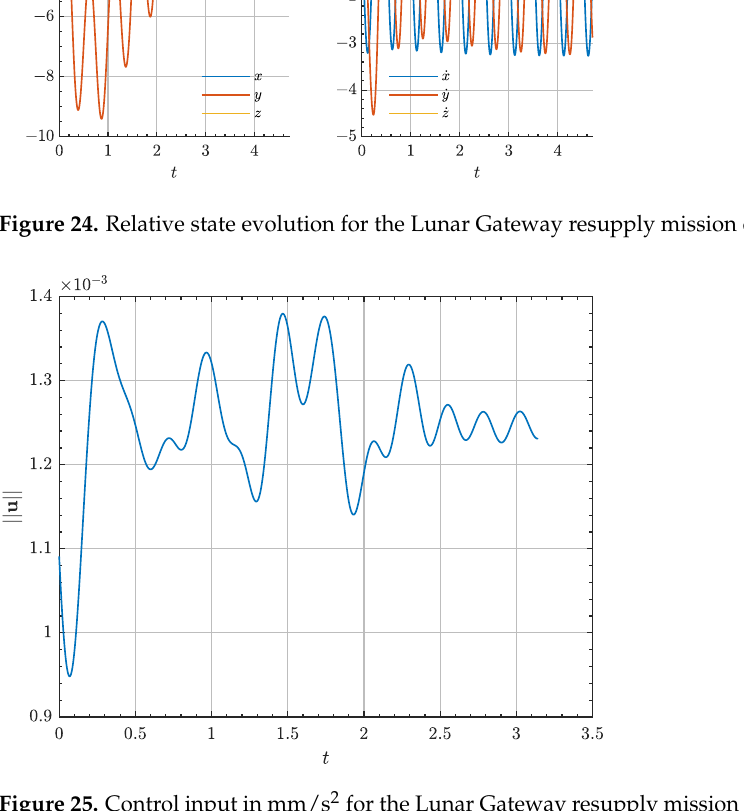
Figure 25. Control input in mm/s 2 for the Lunar Gateway resupply mission during formation flying.